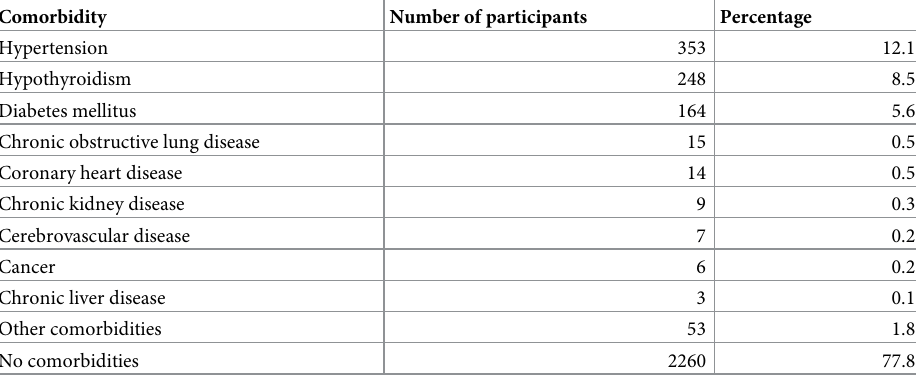
Table 4. Comorbidities in the study participants.